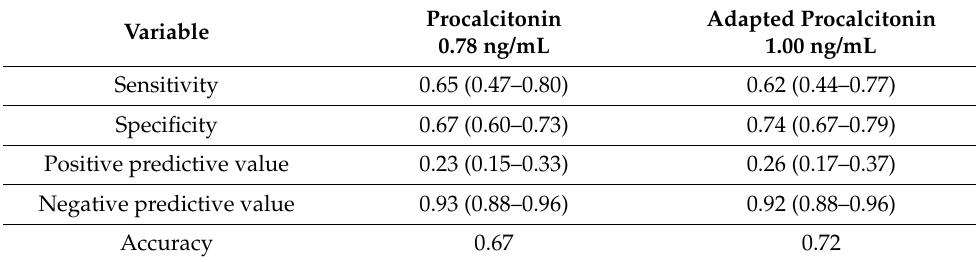
Table 7. Comparison of the efficiency of procalcitonin either with a fixed threshold or a threshold adapted to postoperative renal